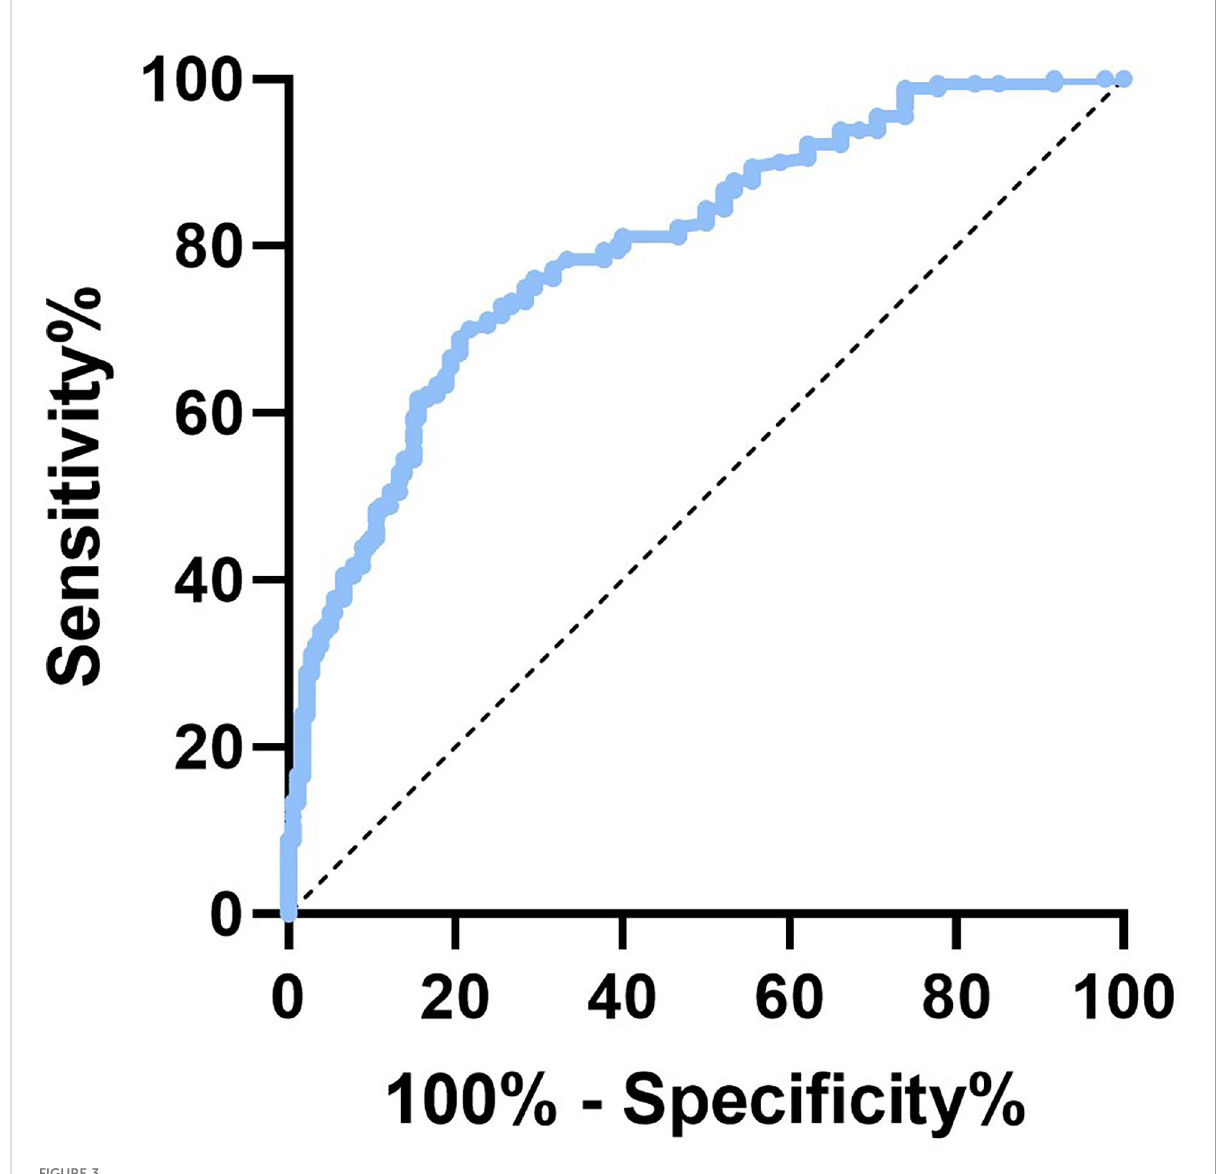
FIGURE 3 The ROC curve of AGEs in predicting fracture risk of postmenopausal T2D